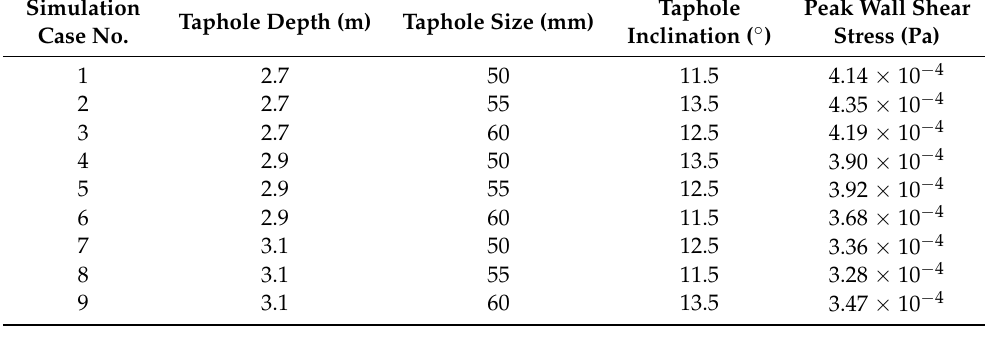
Table 6. Orthogonal design table for the iron tapping optimization and the corresponding peak wall shear stress for each simulation case.